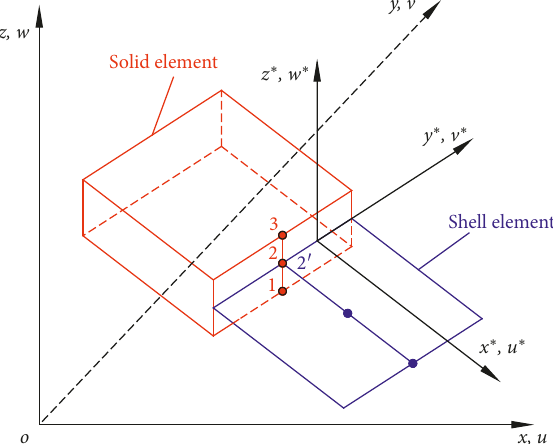
Figure 11: Relationship of solid elements and shell elements at the coupling interface.